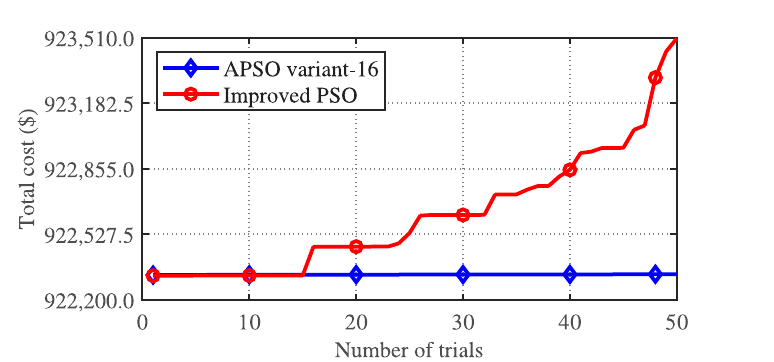
Fig 4. Comparison of minimum costs achieved by APSO variant-16 and Improved PSO for 50 trials for the CSTHTS problem.